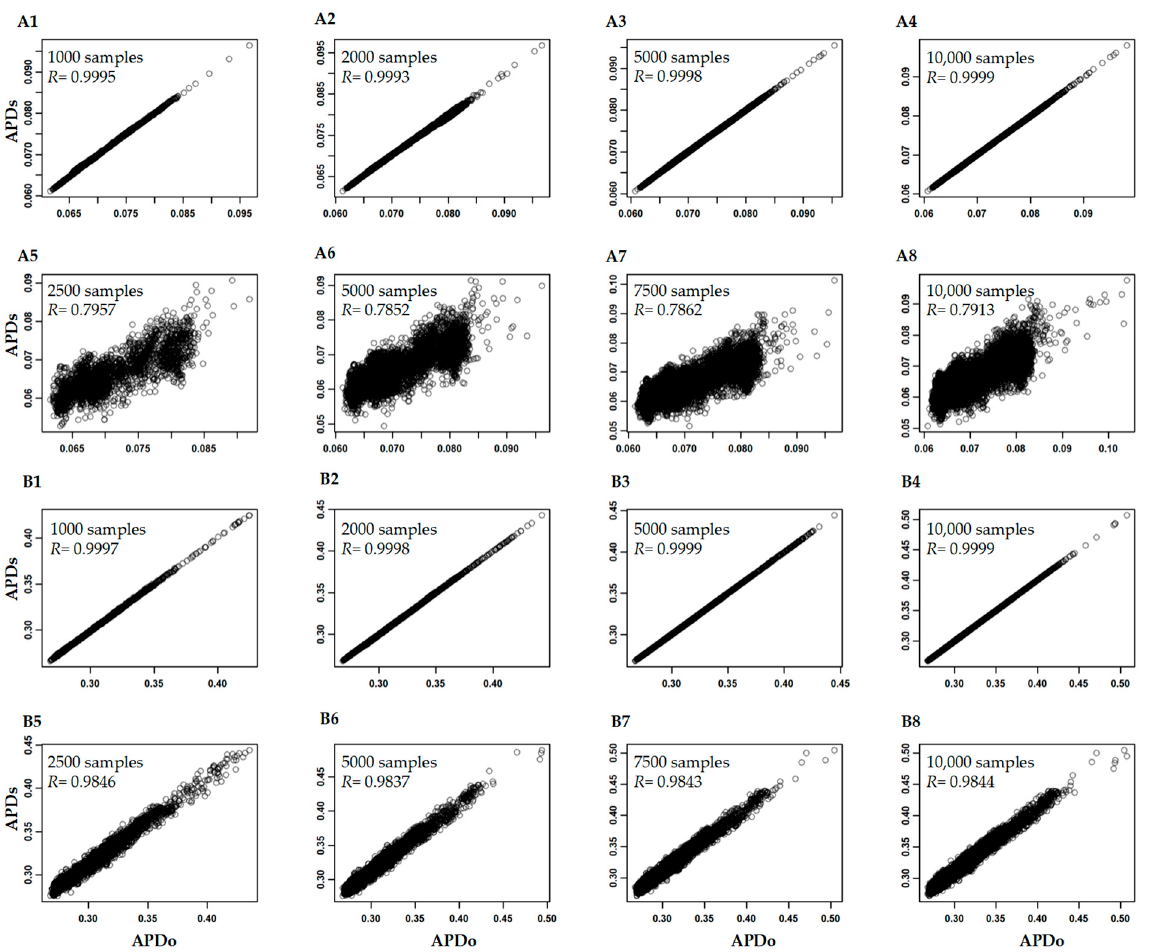
Figure 2. The correlations of APD estimates in the Hordeum vulgare ( A ) and Glycine max ( B ) data sets with all the original SNPs ( A1 – A4 , B1 – B4 ) or randomly selected 1000 SNPs ( A5 – A8 , B5 – B8 ) for all the original samples (APDo) and subject to the random selection of 1000 to 10,000 samples